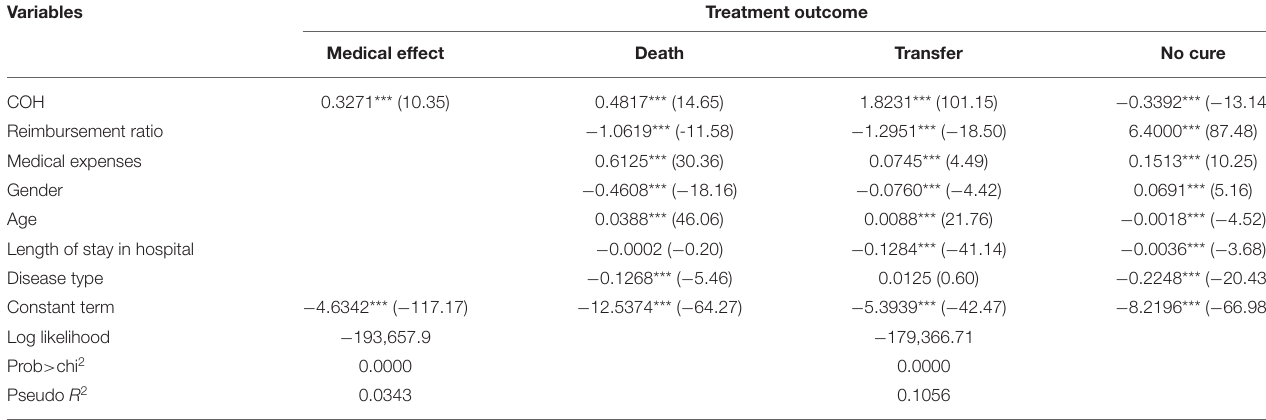
TABLE 4 | The nested multinomial logit (NMNL) model empirical results.